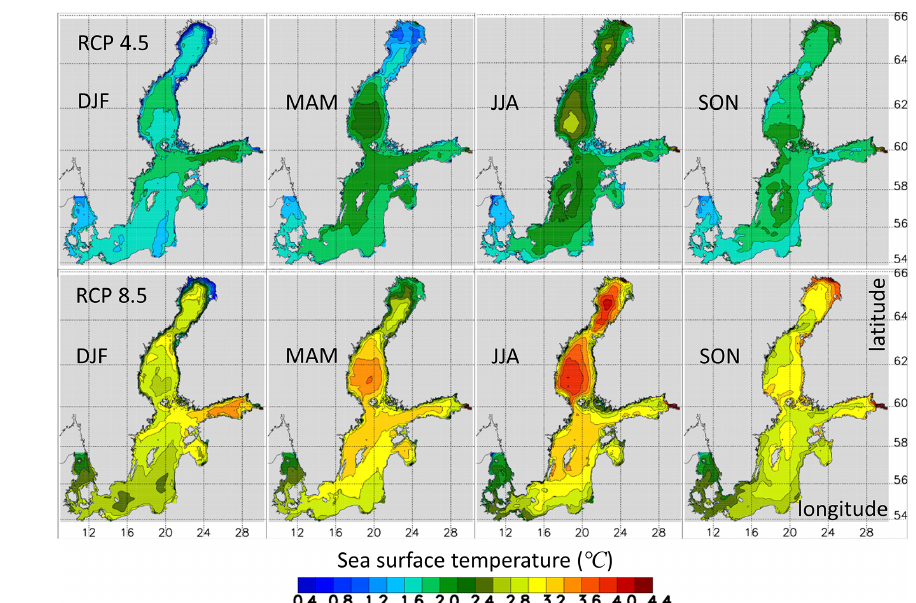
Figure 11. Changes in seasonal mean SST as simulated by the CLIMSEA ensemble. From left to right, mean SST changes (in ◦ C) in winter (December, January and February; DJF), spring (March, April and May; MAM), summer (June, July and August; JJA) and autumn (September, October and November; SON) between 1976–2005 and 2069–2098 under RCP4.5 (upper panels) and RCP8.5 (lower panels). (Source: Meier et al., 2021; their Supplementary Fig. 1 distributed under the terms of the Creative Commons CC-BY 4.0 License, http: //creativecommons.org/licenses/by/4.0/, last access: 6 January